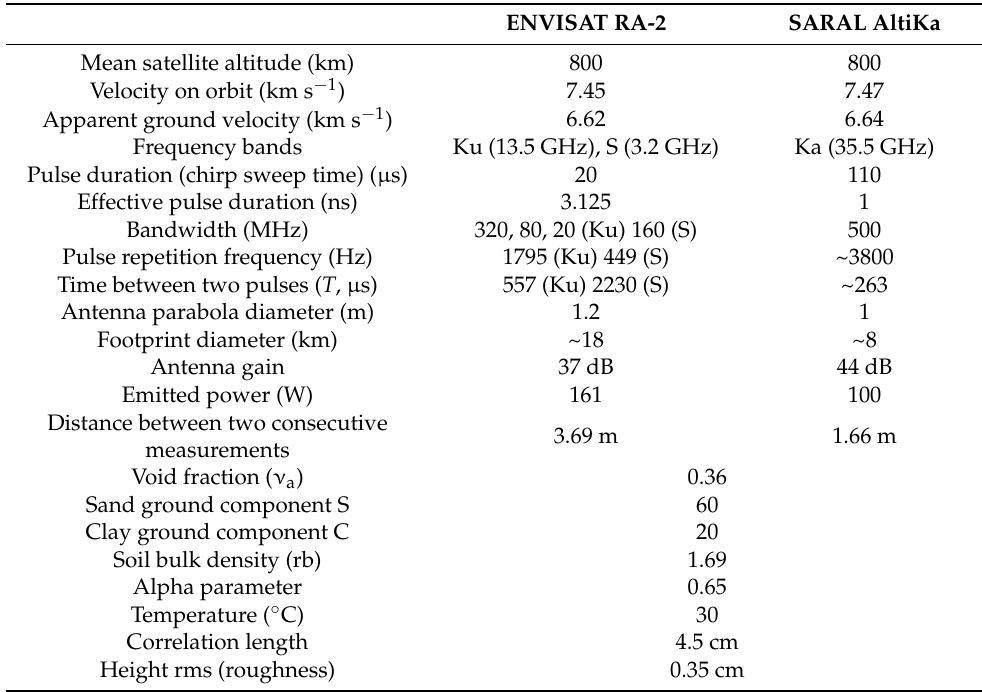
Table A1. Main characteristics of ENVISAT and SARAL altimetry missions and of RA-2 and AltiKa sensors from [37,38].